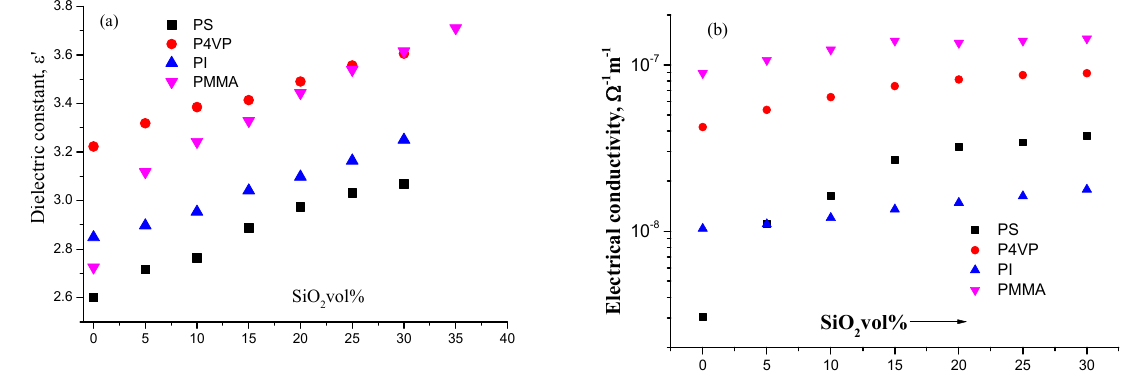
Figure 2. ( a ) The dielectric constant ε as a function of silica content for PS, P4VP, PI and PMMA; ( b ) The electrical conductivity σ as a function of silica content for PS, P4VP, PI and PMMA. Figure 2a shows the relative dielectric constant ε ʹ of pure silica as a function of the applied frequency. This figure reveals that silica has a high dielectric function. The dielectric constant of the